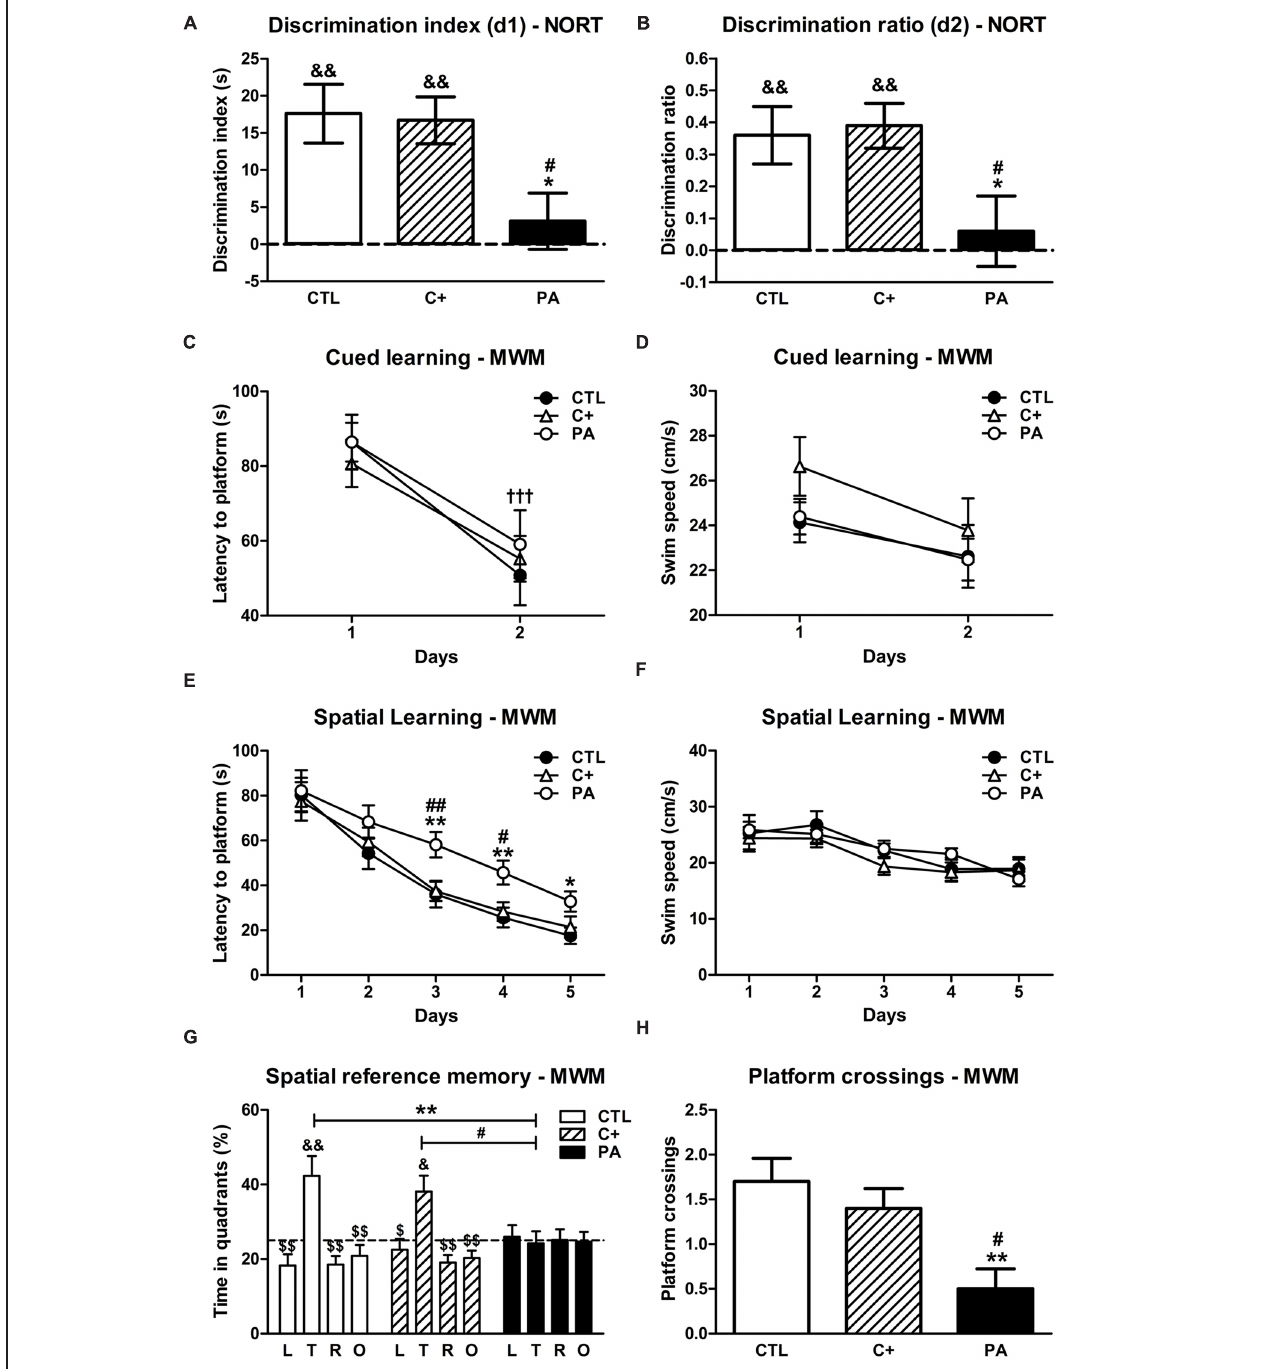
FIGURE 1 | Behavioral assessment. (A) Discrimination indexes and (B) discrimination ratios of the CTL, C + and PA groups in the choice trial of the NORT. ∗ p < 0.05 vs. CTL; # p < 0.01 vs. C + ; && p < 0.01 vs. scores expected by chance (dashed lines). (C) Latencies to platform and (D) swimming speeds of the different experimental groups during the cued learning phase of the MWM. ††† p < 0.001 vs. day 1 for all the groups. (E) Latencies to platform and (F) swimming speeds of the different experimental groups during the spatial learning phase of the MWM. ∗ p < 0.05 vs. CTL; ∗∗ p < 0.01 vs. CTL; # p < 0.05 vs. C + ; ## p < 0.01 vs. C + . (G) Percentages of time spent in the four quadrants and (H) number of platform crossings during the probe trial. ∗∗ p < 0.01 vs. the percentage of time spent in the target quadrant by the PA group (G) or vs. CTL (H) ; # p < 0.05 vs. the percentage of time spent in the target quadrant by the PA group (G) or vs. C + (H) ; $ p < 0.05 and $$ p < 0.01 vs. the percentage of time spent in the target quadrant within the same group; & p < 0.05 and && p < 0.01 vs. the percentage of time expected by chance (25%; dashed line). CTL, control group; C + , cesarean section group; PA, perinatal asphyxia group; NORT, Novel Object Recognition Test; MWM, Morris water maze test; L, left quadrant; T, target quadrant; R, right quadrant; O, opposite quadrant.